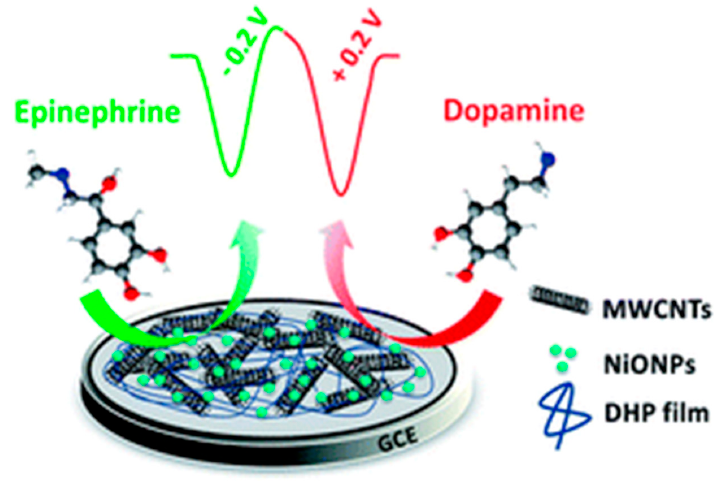
Figure 4. Schematic of the simultaneous detection of epinephrine and dopamine using multiwalled carbon nanotubes (MWCNTs) and dihexadecylphosphate (DHP) film [56]. Copyright 2014, Royal Society of Chemistry.